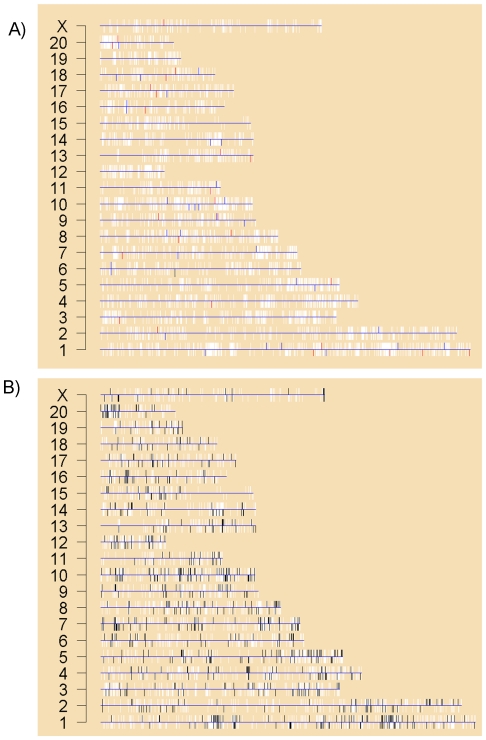
Genome-Wide Mapping of Differential Expression.To determine if differentially-expressed ProbeSets were localized to specific portions of the rat genome we plotted the entire genome, with one chromosome per line. Each gene was plotted with a white bar representing its location on the chromosome and its position on the plus (up) or minus (down) strand. A) Genes showing AHR-dependent expression have been colour-coded in red (down-regulated) or blue (up-regulated). The AHR itself is in black on chromosome 6. B) Genes displaying strain-specific mRNA abundances were identified by using a linear model and selected ProbeSets where the F p-value<0.001. These genes are plotted in black, and form clear clusters throughout the genome.